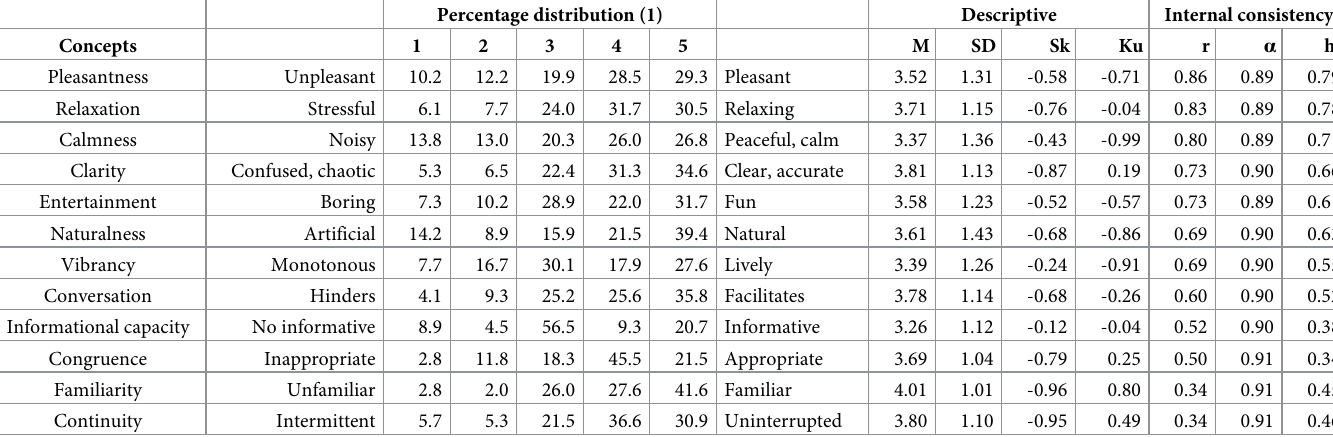
Table 4. Descriptive and internal consistency data of ACAS-12 in its version with five measurement attributes (polychoric matrices; n =